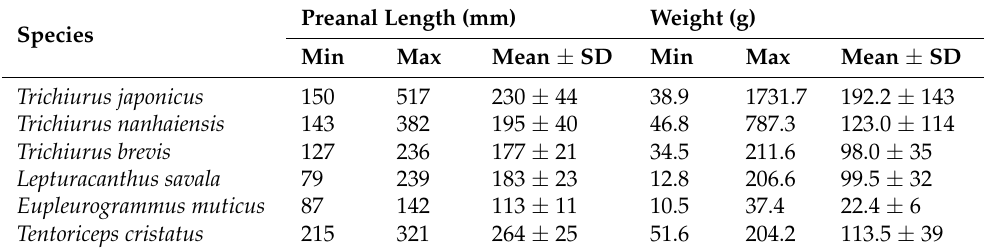
Table 2. Preanal length and weight of six species of Trichiuridae in the coastal waters of China.